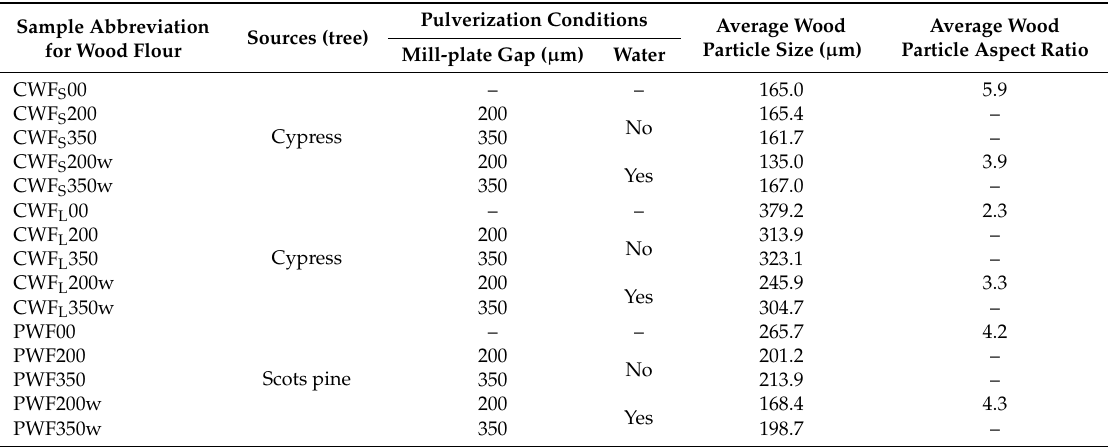
Table 1. List of different types of wood flours and composite samples with their